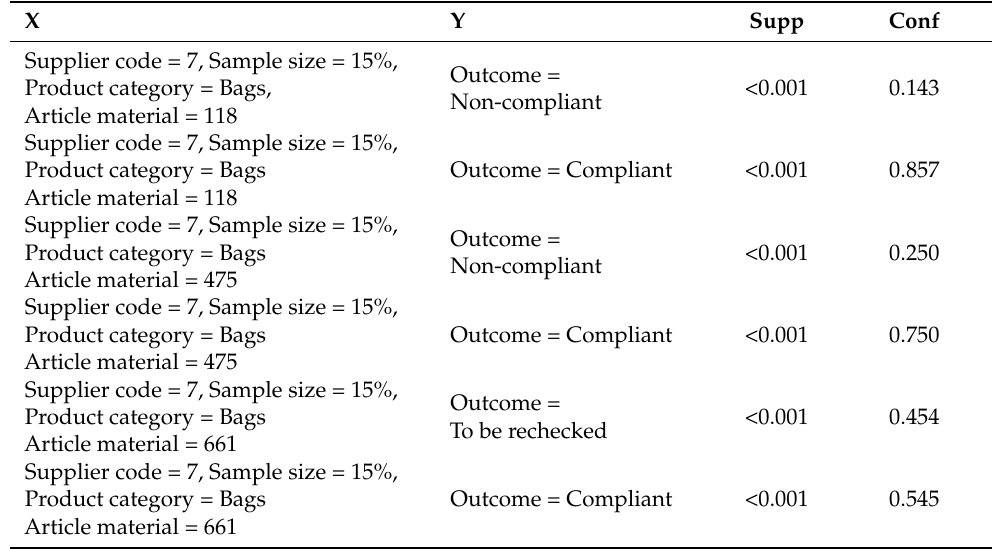
Table 3. Association rules relating to supplier code, sample size, product category, article material, and